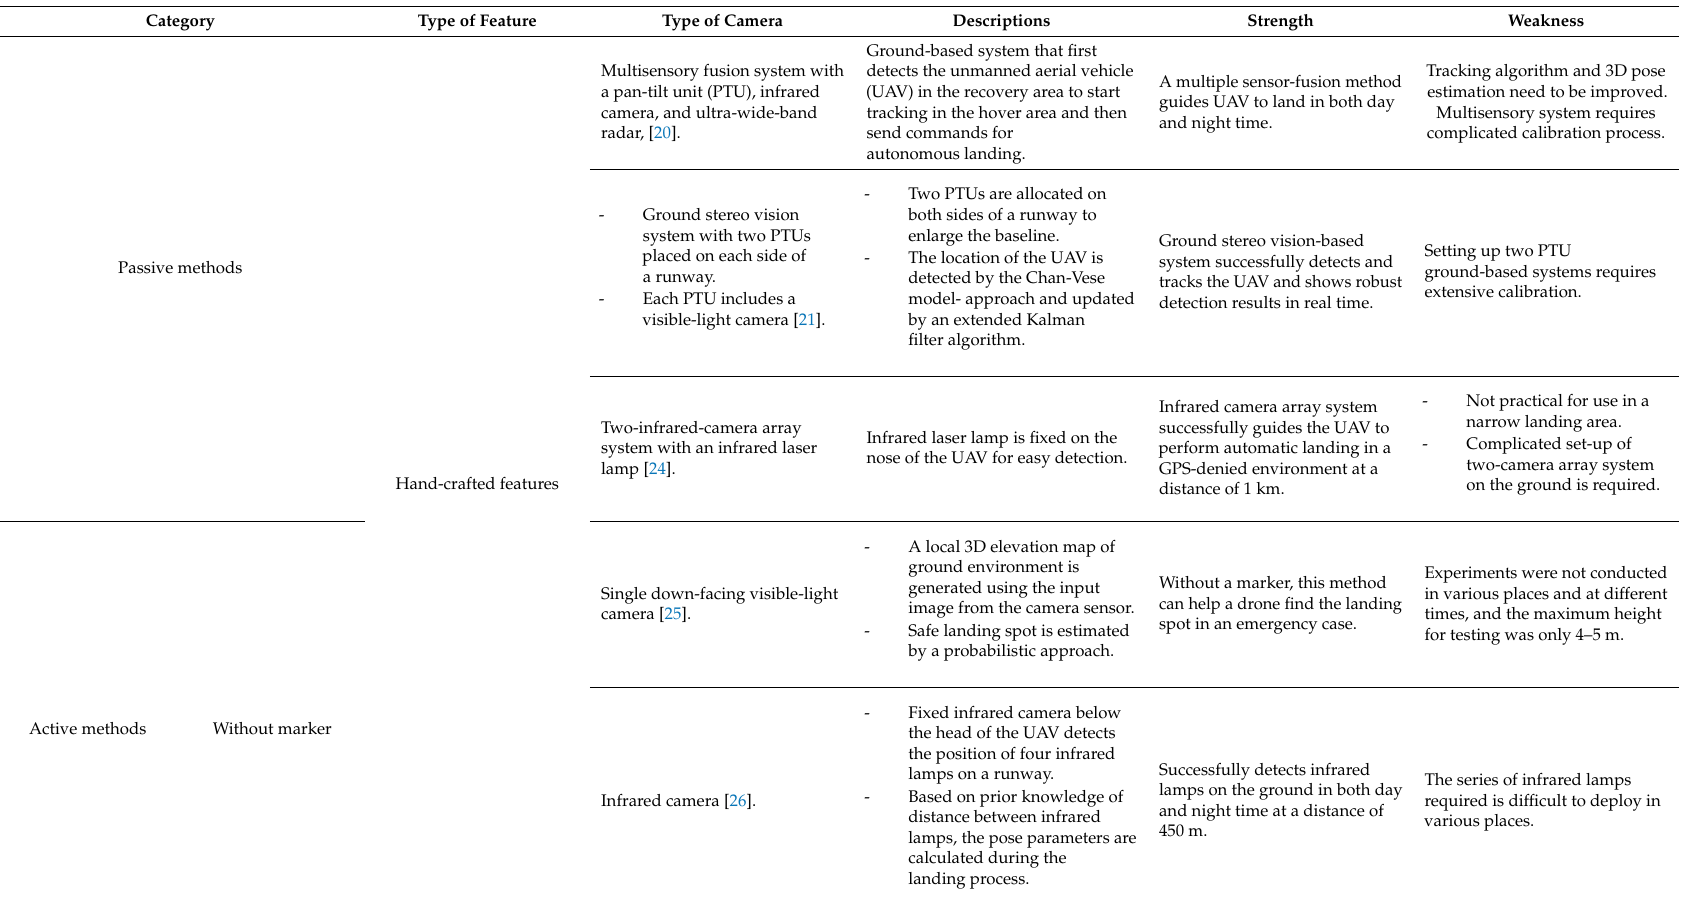
Table 1. Summary of comparisons of proposed and previous